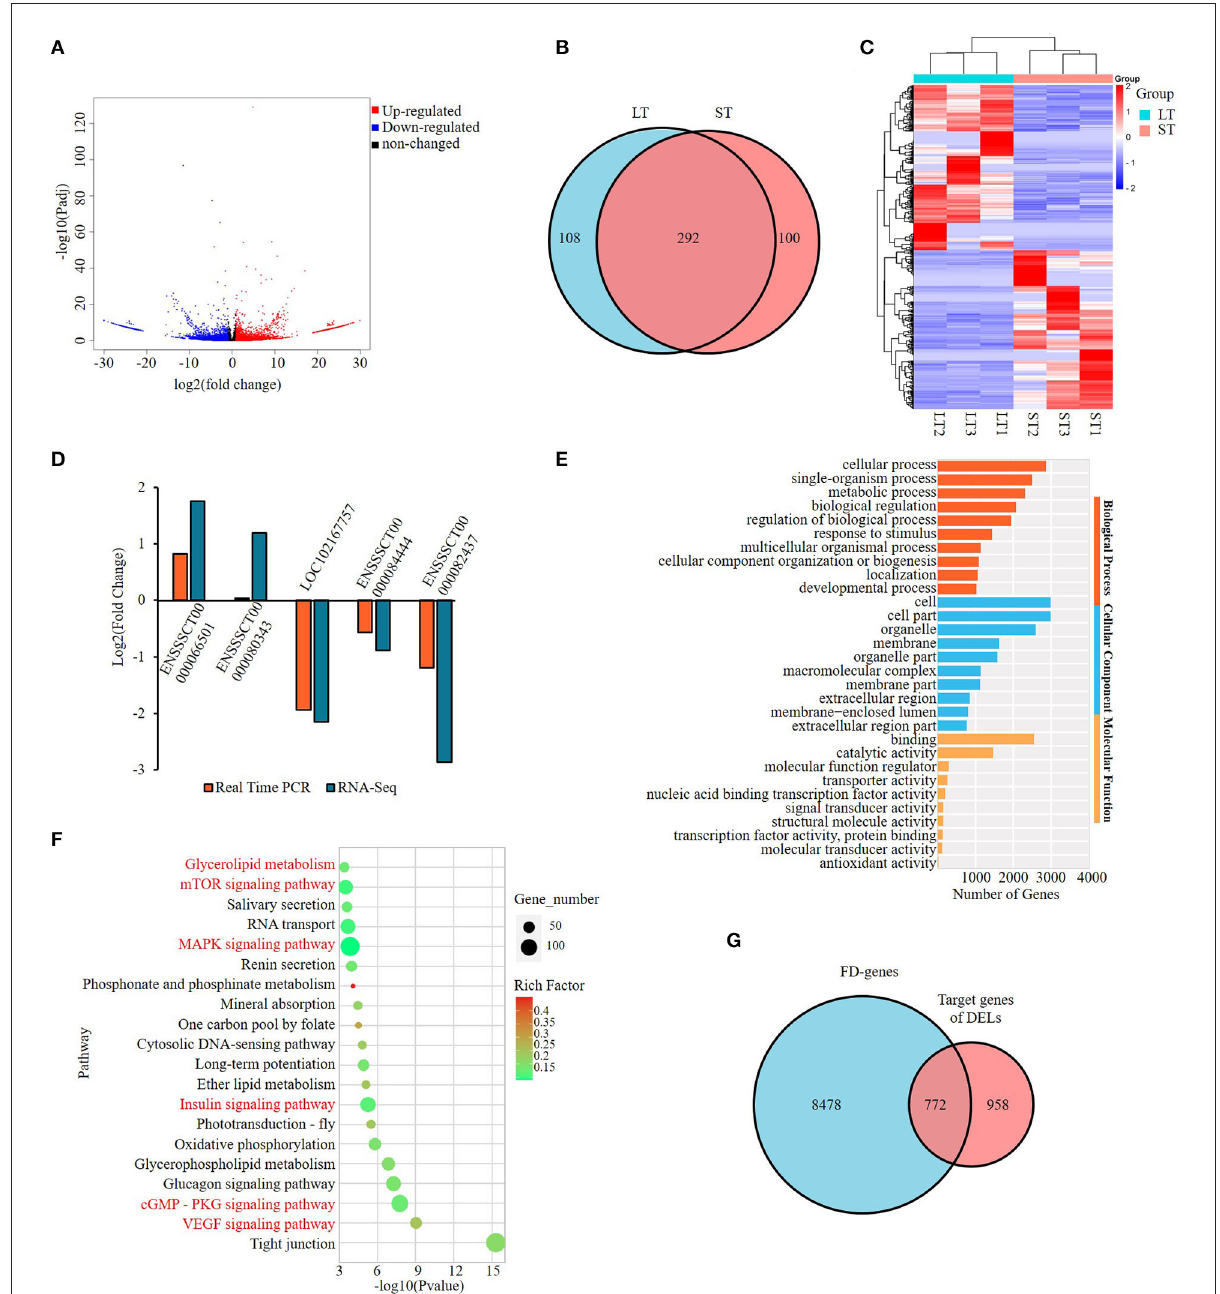
FIGURE2 Screening and enrichment analysis of the differentially expressed lncRNAs (DELs) in semitendinosus compared with longissimus thoracis. (A) Volcano plot of DELs; (B) Venn diagram of DELs; (C) Hierarchical clustering heatmap of the top DELs; (D) Real-time PCR validation of DELs; (E) Top 10 GO terms enriched by cis -target genes of DELs in each category; (F) Top 20 KEGG pathways significantly enriched by the cis -target genes of DELs. Fat-related pathways were indicated with red; (G) Venn diagram of cis -target genes of DELs and fat deposition